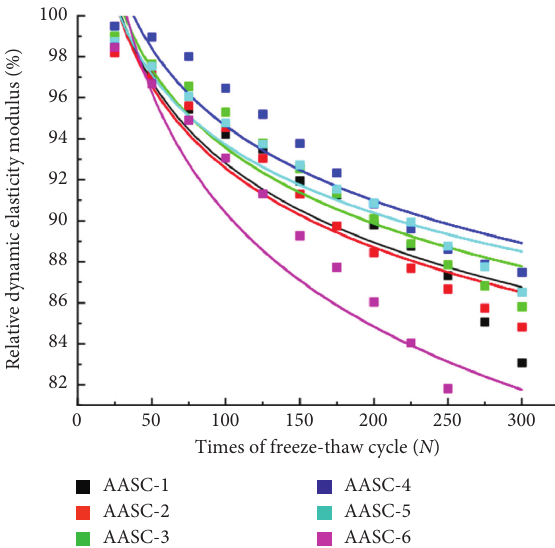
Figure 15: Relative dynamic elastic modulus attenuation power function model.